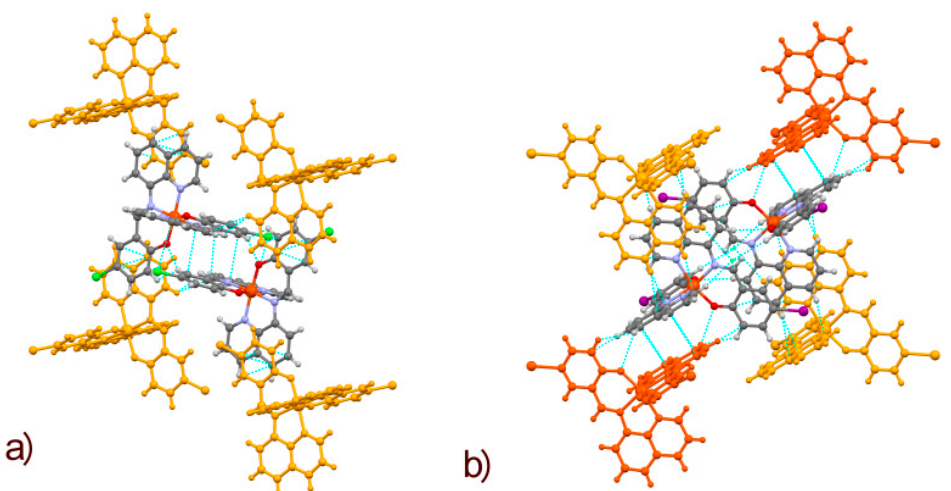
Figure 6. View of the interdimer intralayer arrangements of ( a ) 3.Cl.MeCN.H 2 O and ( b ) 5.Cl.MeOH.2.5H 2 O , exhibiting type I and type II Dimer Layers arrangements respectively. The cations depicted in orange show relatively strong ππ interactions to the cations from the central dimer.